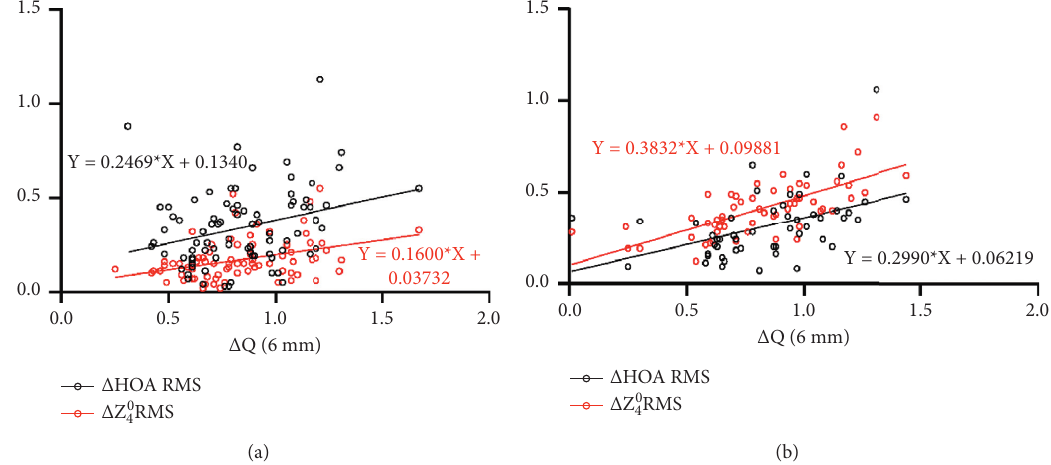
Figure 5: Correlation between the change of Q value and the change of HOA and spherical aberration ( Z 40 ) in the FS-LASIK (a) and Trans- PRK (b)